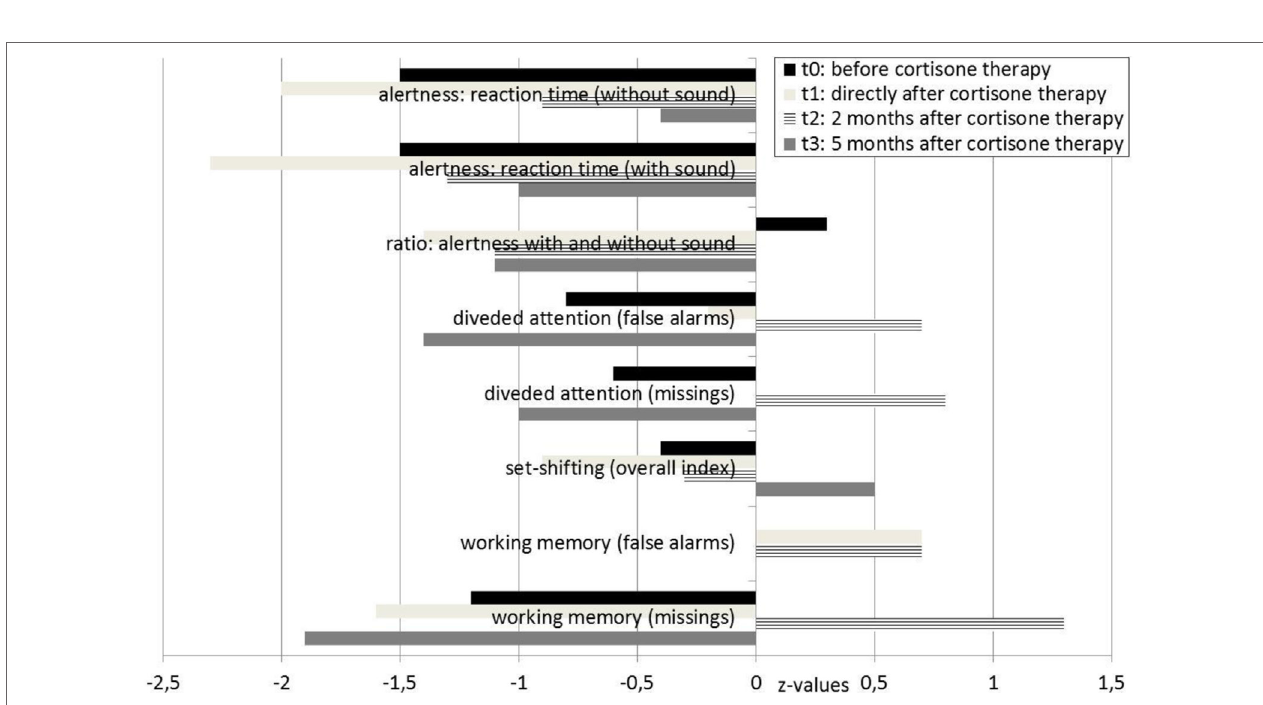
FIGURe 3 | test for attentional performance .